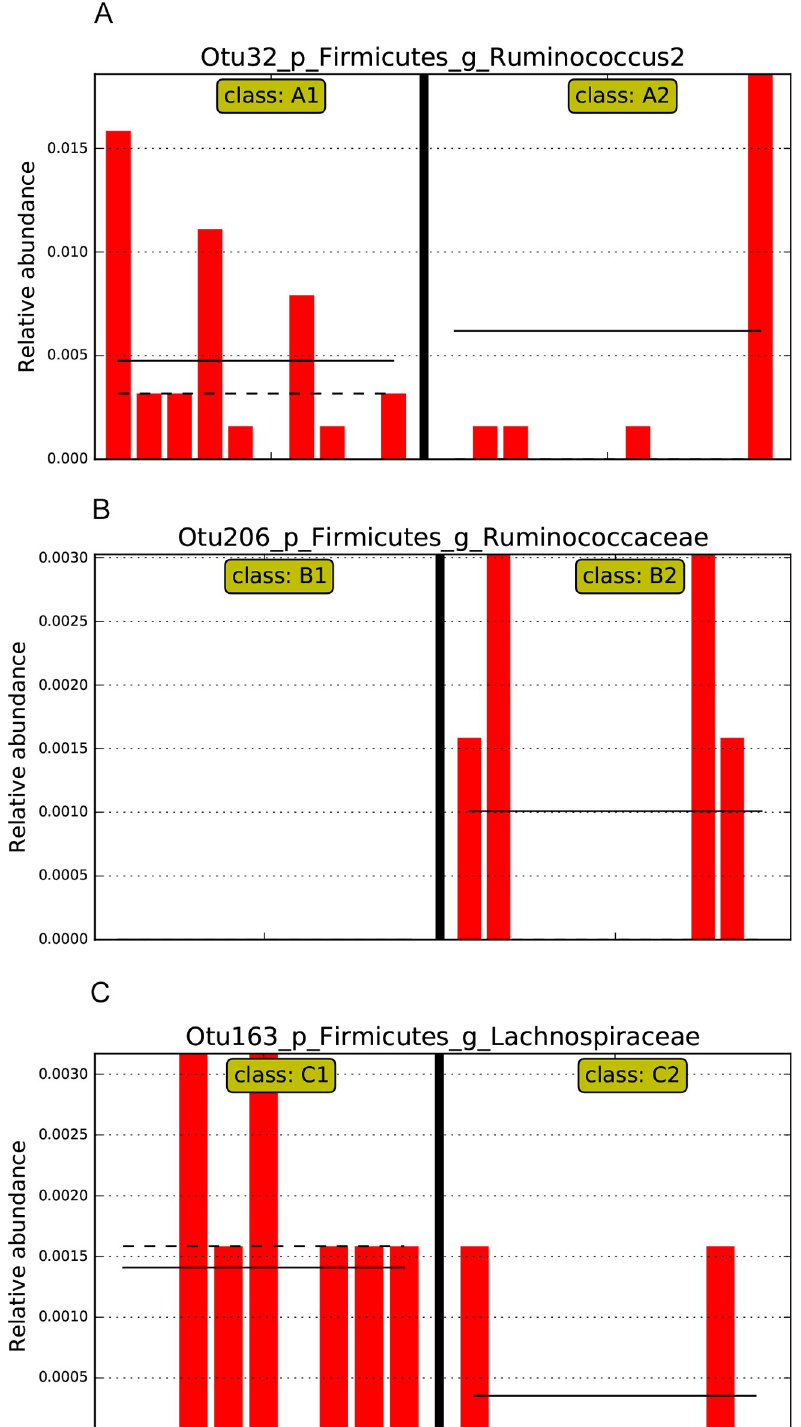
Fig 6. LEfSe analysis of selected operational taxonomic units of individual participants. Relative abundance of (A) OTU32 ( Ruminococcus torques ) for Group A, (B) OTU206 ( Negativibacillus massiliensis ) for Group B, and (C) OTU163 ( Mediterraneibacter glycyrrhizinilyticus) for Group C are shown. Each bar represents one participant, and the order of participants is the same for week 0 and week 6. Solid horizontal lines represent mean relative abundance whereas the dashed horizontal lines represent the median relative abundance. A1 = Group A (fermented vegetable) at